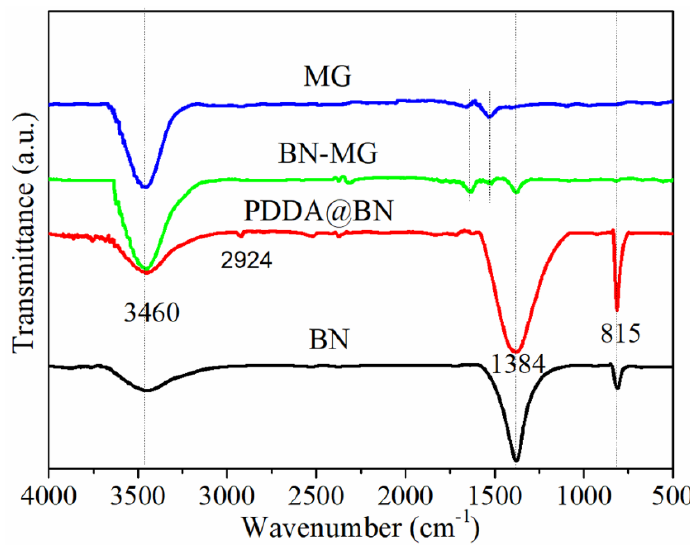
Figure 4. FT − IR spectra of BN, PDDA@BN, MG, and BN − MG. The crystal structure of PDDA@BN, MG, and BN − MG are shown in Figure 5. The strong and sharp peak at 2 θ = 26.0 ◦ is the characteristic peak of MGcorresponding to the (002) crystal plane diffraction of MG. The strong characteristic (002) crystal plane